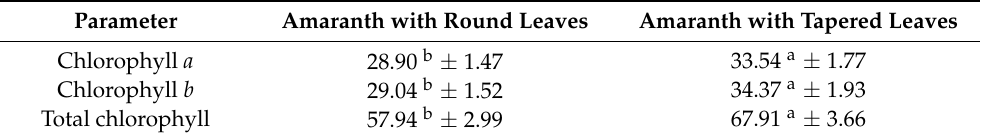
Table 1. The chlorophyll content (mg/100 g fresh weight) of green amaranth varieties. Parameter Amaranth with Round Leaves Amaranth with Tapered Leaves Chlorophyll